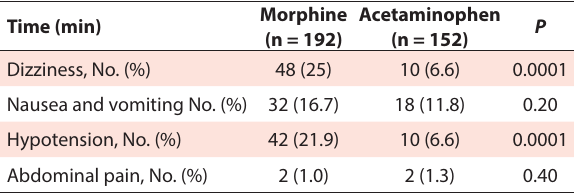
Table 3. Comparison of treatment side effects between the two groups Time (min)